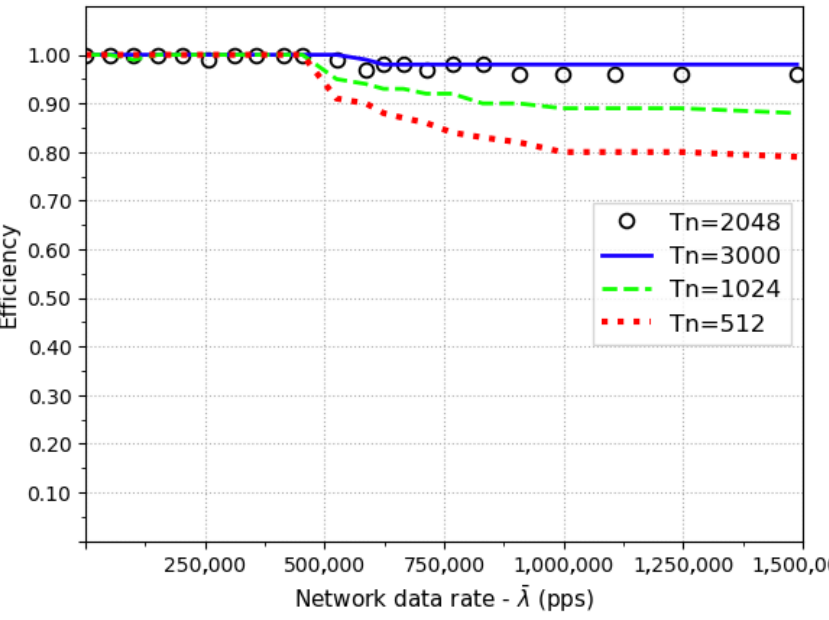
Figure 14. Performance comparison between implemented scenarios on the real probe with n-based threshold